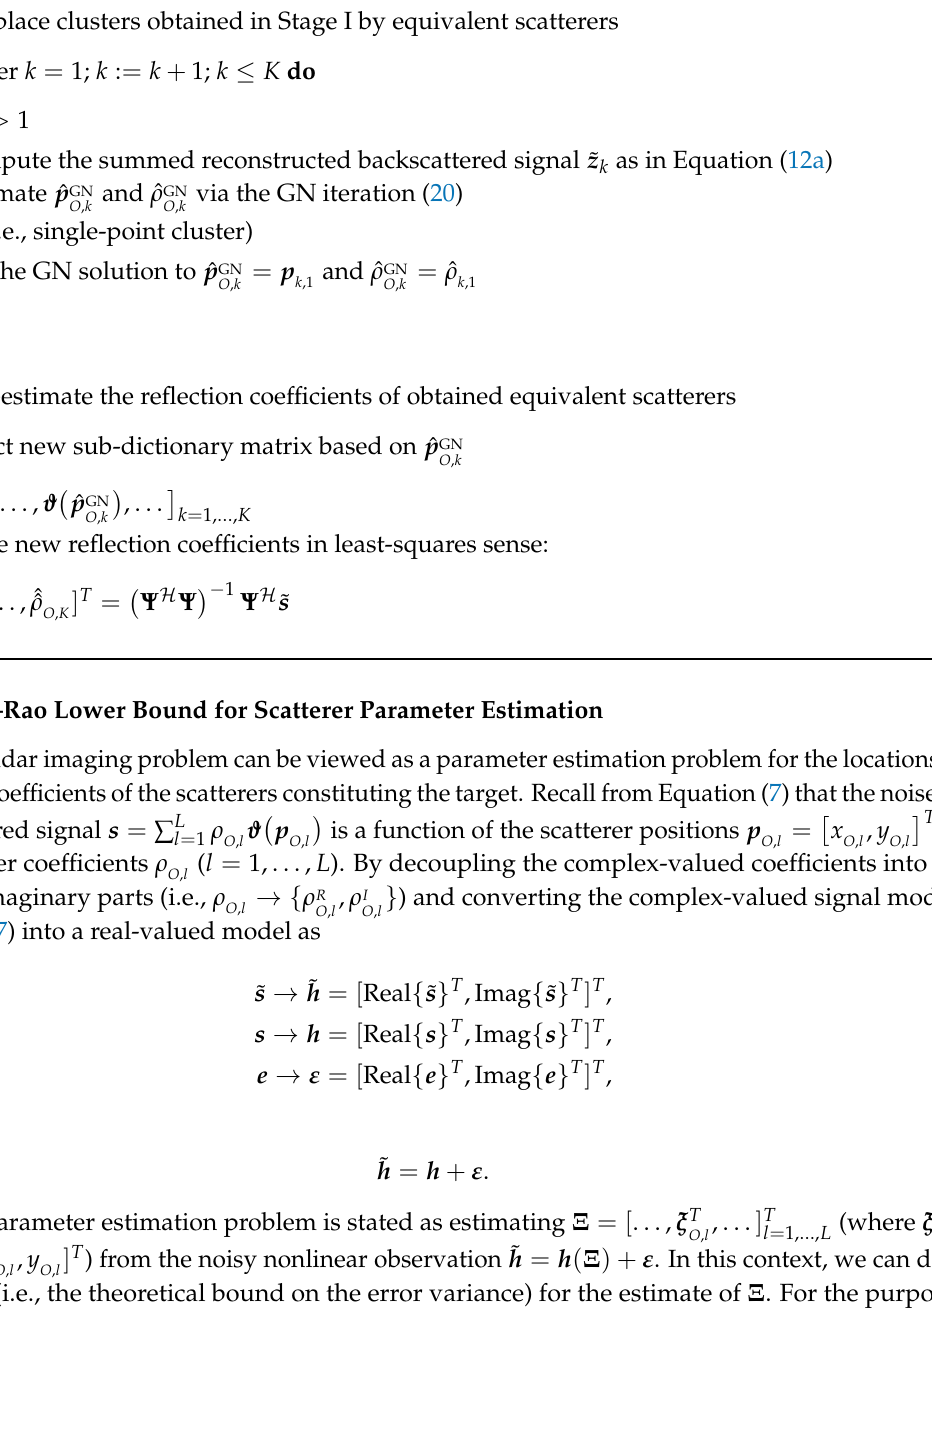
Table 1. Computational steps of stage